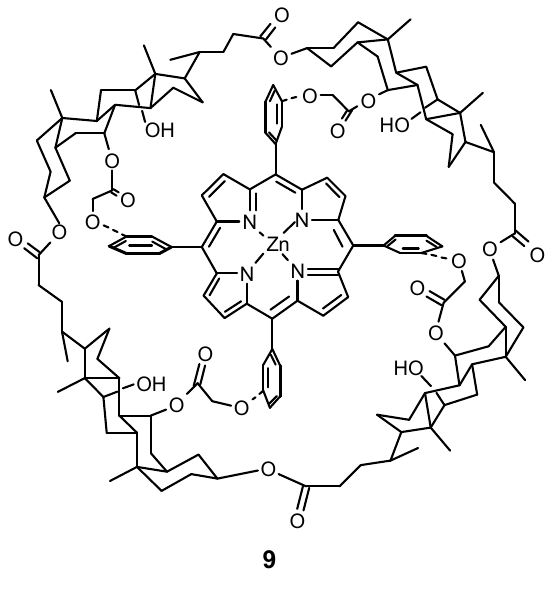
Figure 3. A cyclocholate-capped porphyrin